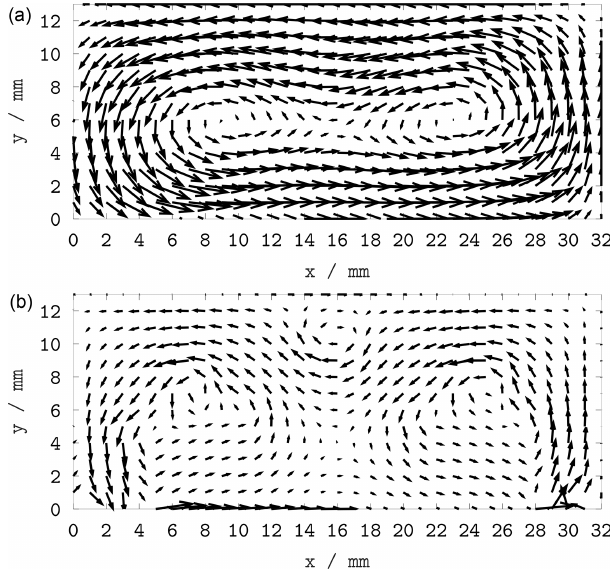
Figure 3. Eddy currents in the carrier plate at the signal frequency 10Hz (a) and 100kHz (b)